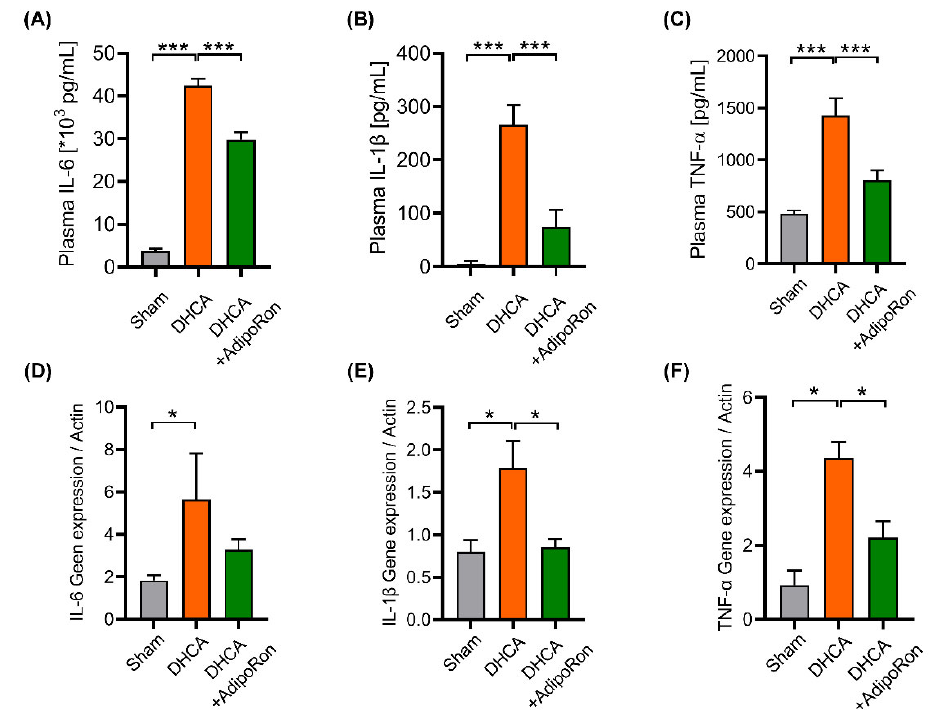
Figure 4. Assessment of anti-inflammation effects of AdipoRon in DHCA rats. Blood samples were collected into the tubes containing EDTA at the end of the surgical procedure and then centrifuged (3000 rpm for 20 min at 4 °C) within 30 min. The upper layers of plasma were stored at − 80 °C for analysis. Concentrations of IL-6 ( A ), IL-1 β ( B ) and TNF- α ( C ) were calculated based on a comparison of standard concentrations provided by the ELISA kit (n = 6). Rats were sacrificed and the brain was collected at the end of the surgery. mRNA expression of the IL-6 ( D ), IL-1 β ( E ) and TNF- α ( F ) in the brain was measured relative to Actin by quantitative real-time polymerase chain reaction. Data are presented as the mean ± error of median (SEM). Student’s t test was used to compare the differences between two groups. IL-6: interleukin 6, IL-1 β : interleukin 1 β ; TNF- α : tumor necrosis factor α ; DHCA: deep hypothermia circulatory arrest group; SHAM: sham group. * p < 0.05 and *** p < 0.001.